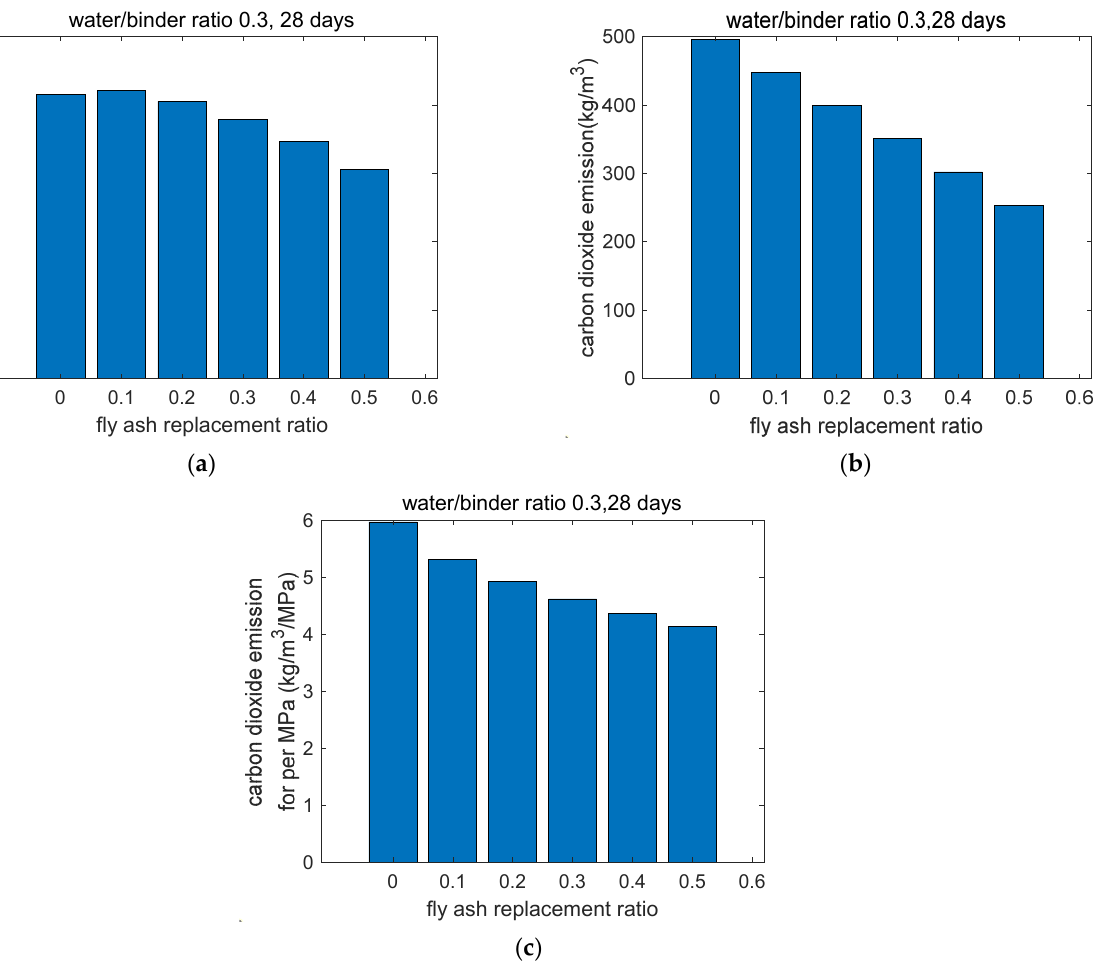
Figure 6. CO 2 emissions for composite concrete with W/B ratio = 0.3 at 28 days. ( a ) Strength at 28 days. ( b ) Total CO 2 emissions. ( c ) CO 2 emissions for 1 MPa strength.